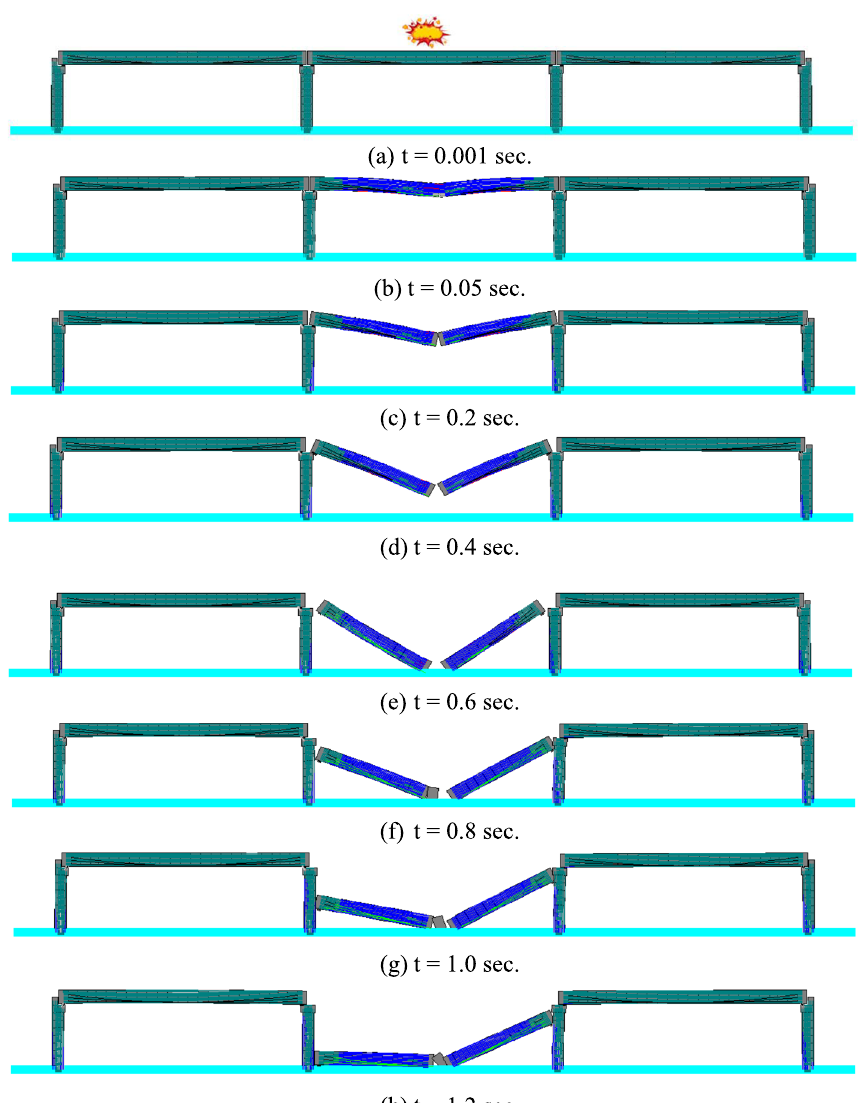
Fig. 11 Collapse mechanism of the prestressed girder under blast